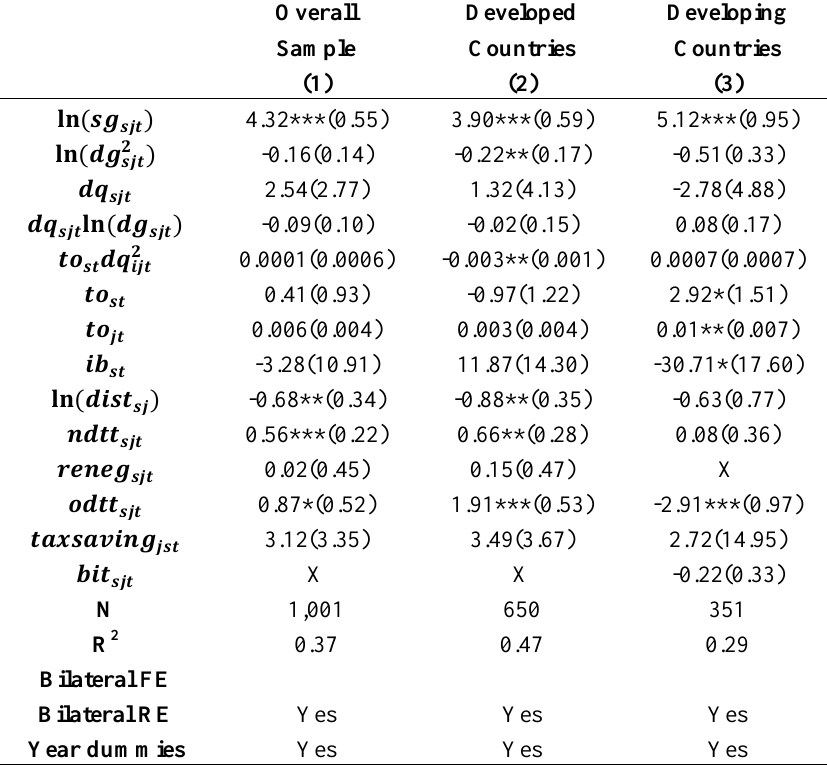
Table 8 : Effect of DTTs and the Territorial Tax System on Spanish inbound FDI: Types of